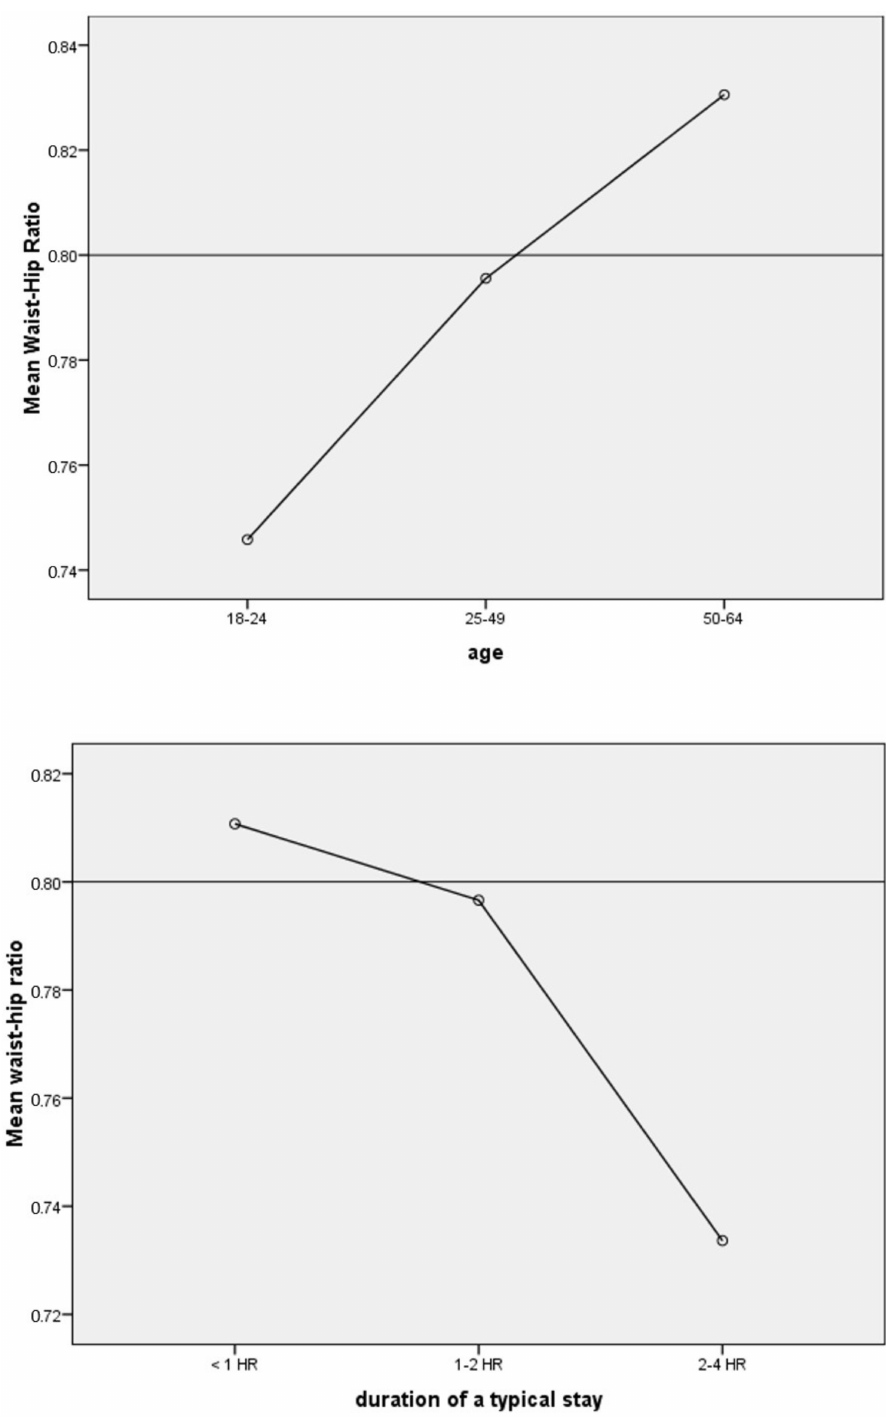
Figure 3. Charts displaying the relationship between age and duration and WHR. The line at 0.8 represented a low-risk WHR, as recommended by WHO